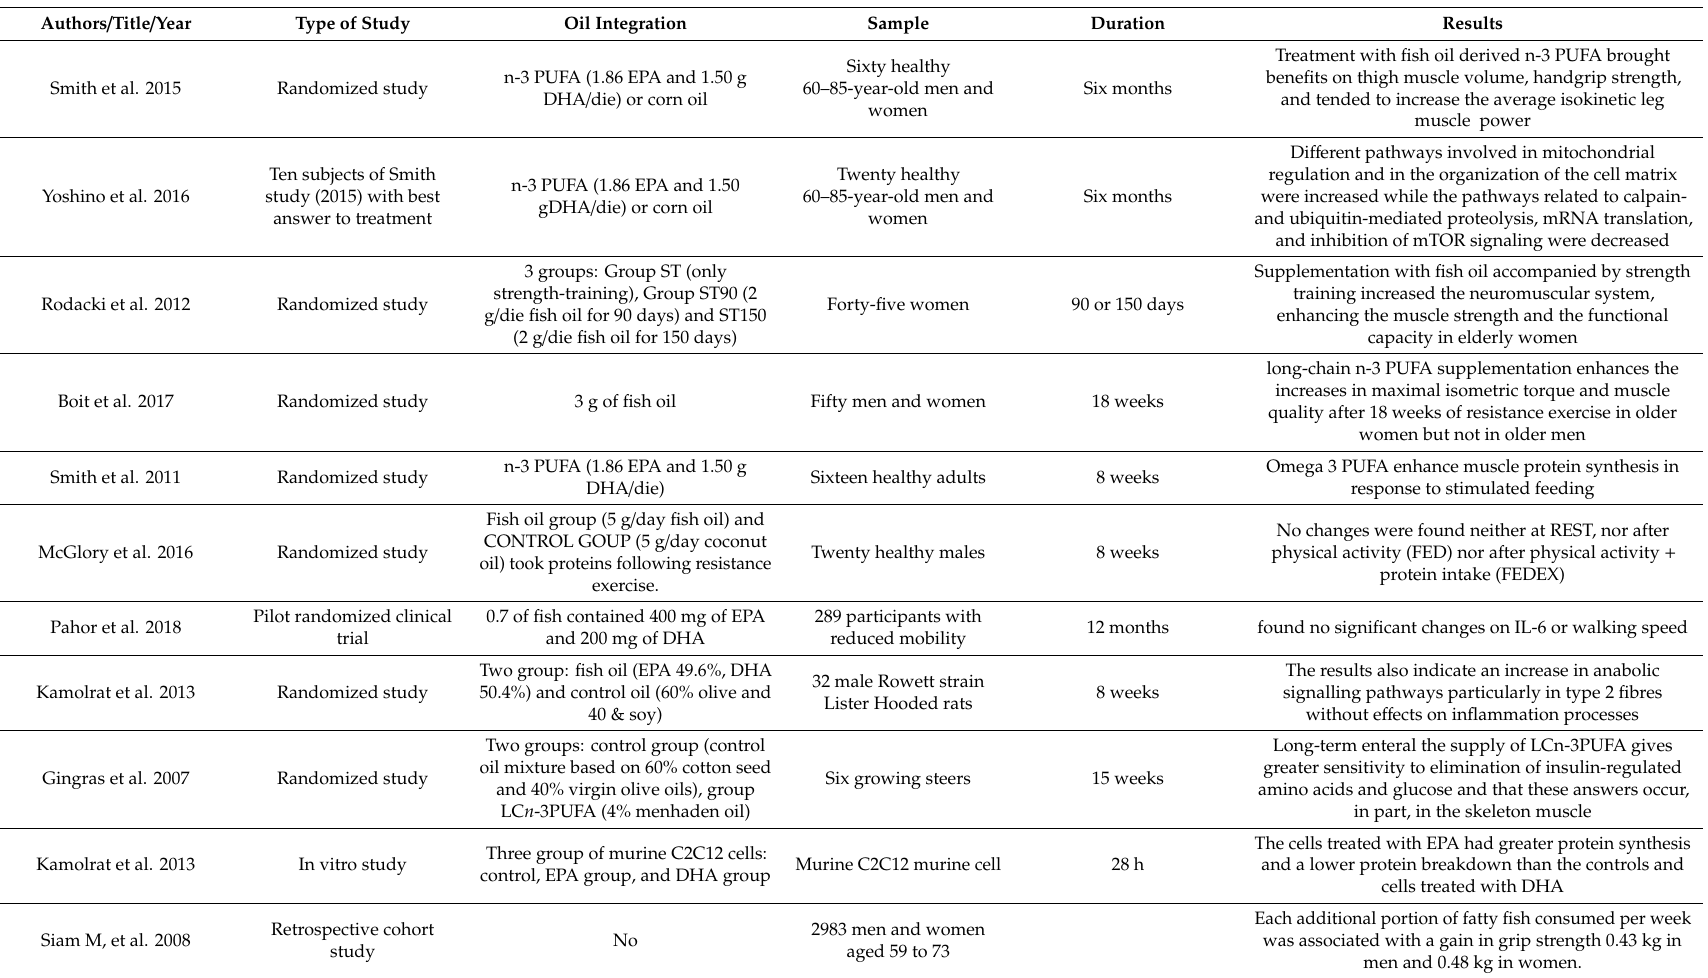
Table 1. Summary of studies of omega-3 fatty acids considered in this narrative